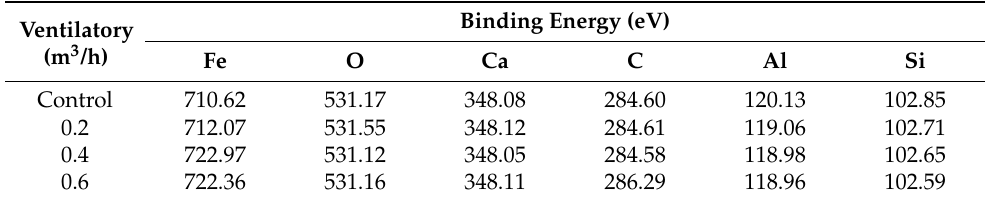
Table 7. Binding energy of inner layer electrons of mineral surface elements at different ventilatory volumes.